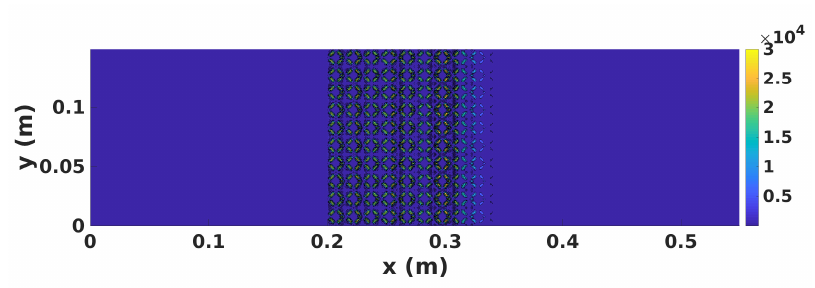
(cid:12) (cid:12) (cid:12) (cid:12) − p recons (cid:12) p ref (cid:12) (Pa) - N s = 10 - s